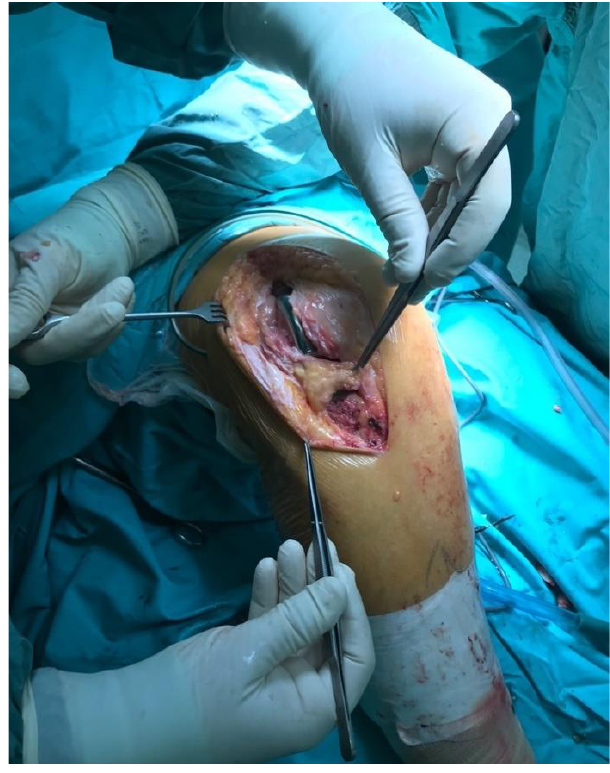
Figure 5. Closure technique.